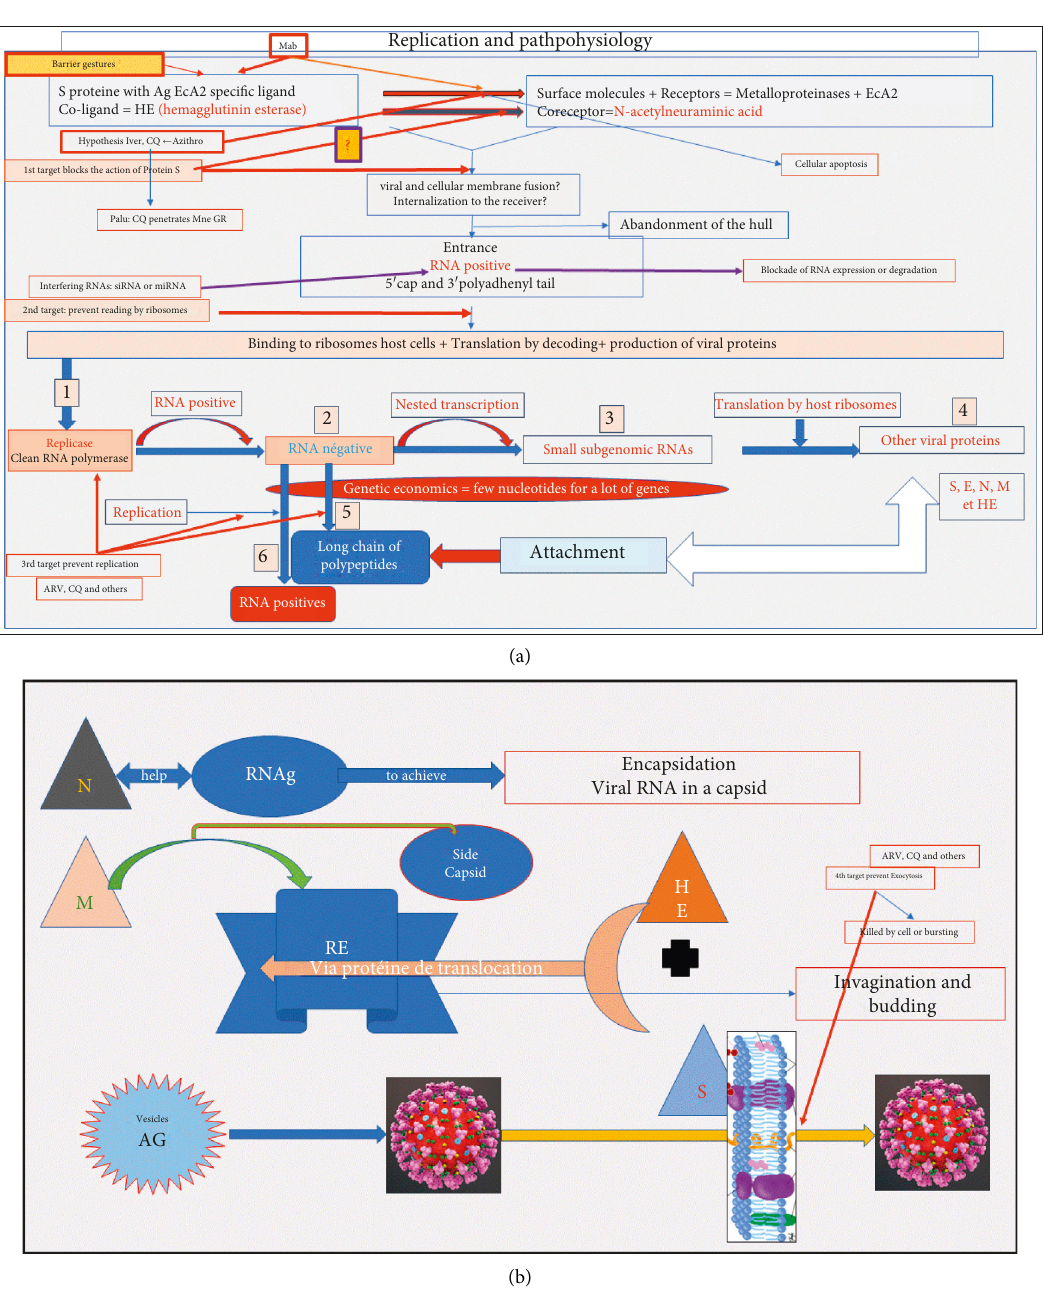
Figure 3: (a) Replication scheme, pathophysiology, and potential therapeutic targets (Source: this study). (b) Diagram (continued) of replication, pathophysiology, and potential therapeutic targets (Source: https://wikipedia.org and this